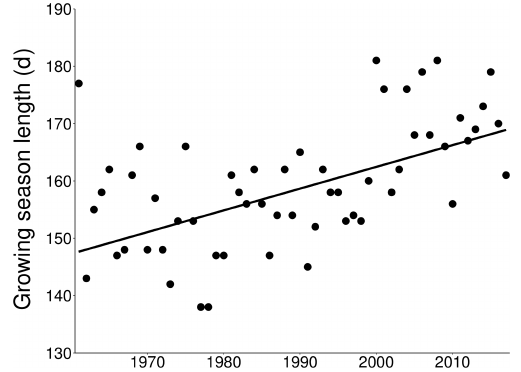
Figure 7. Schmidt stability calculated from simulated water temper- ature between 1961 and 2017 (Sen’s slope: 5.365Jm − 2 per decade, p <